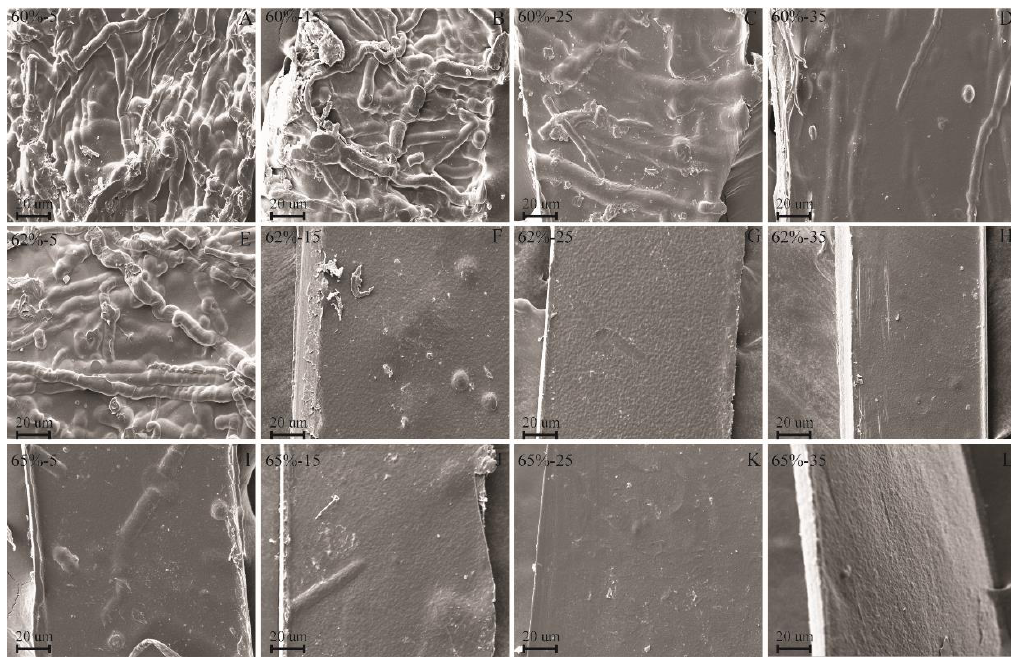
Figure 4. Scanning electron microscopy (SEM) images of the regenerated cellulose films ( A for 60%-5, B for 60%-15, C for 60%-25, D for 60%-35, E for 62%-5, F for 62%-15, G for 62%-25, H for 62%-35, I for 65%-5, J for 65%-15, K for 65%-25 and L for 65%-35).